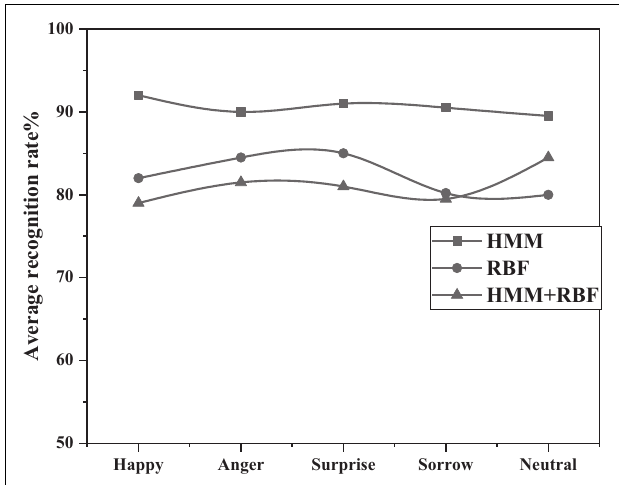
FIGURE 10 | Comparison of recognition rates of three algorithms.